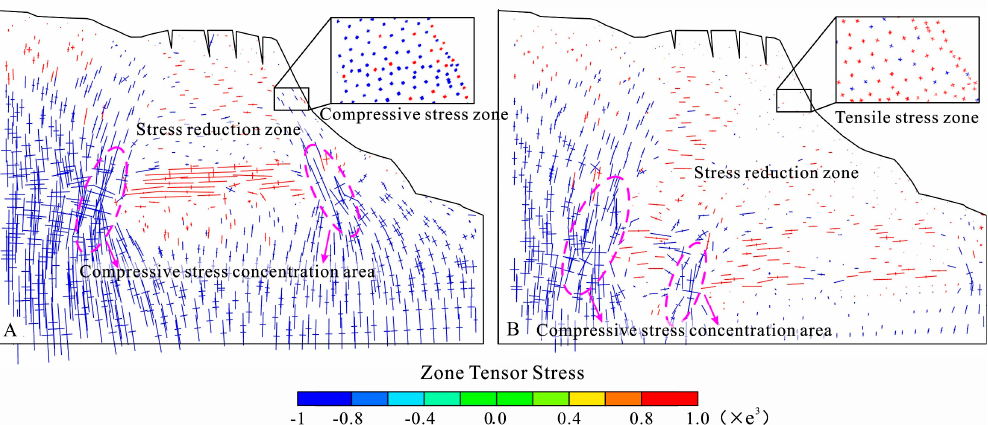
Figure 17. Evolution of stress field under underground mining condition: ( A ) mining stages I − II; ( B ) mining stages I − XII. Note: the blue component means compression stress, and magenta means tensile stress.